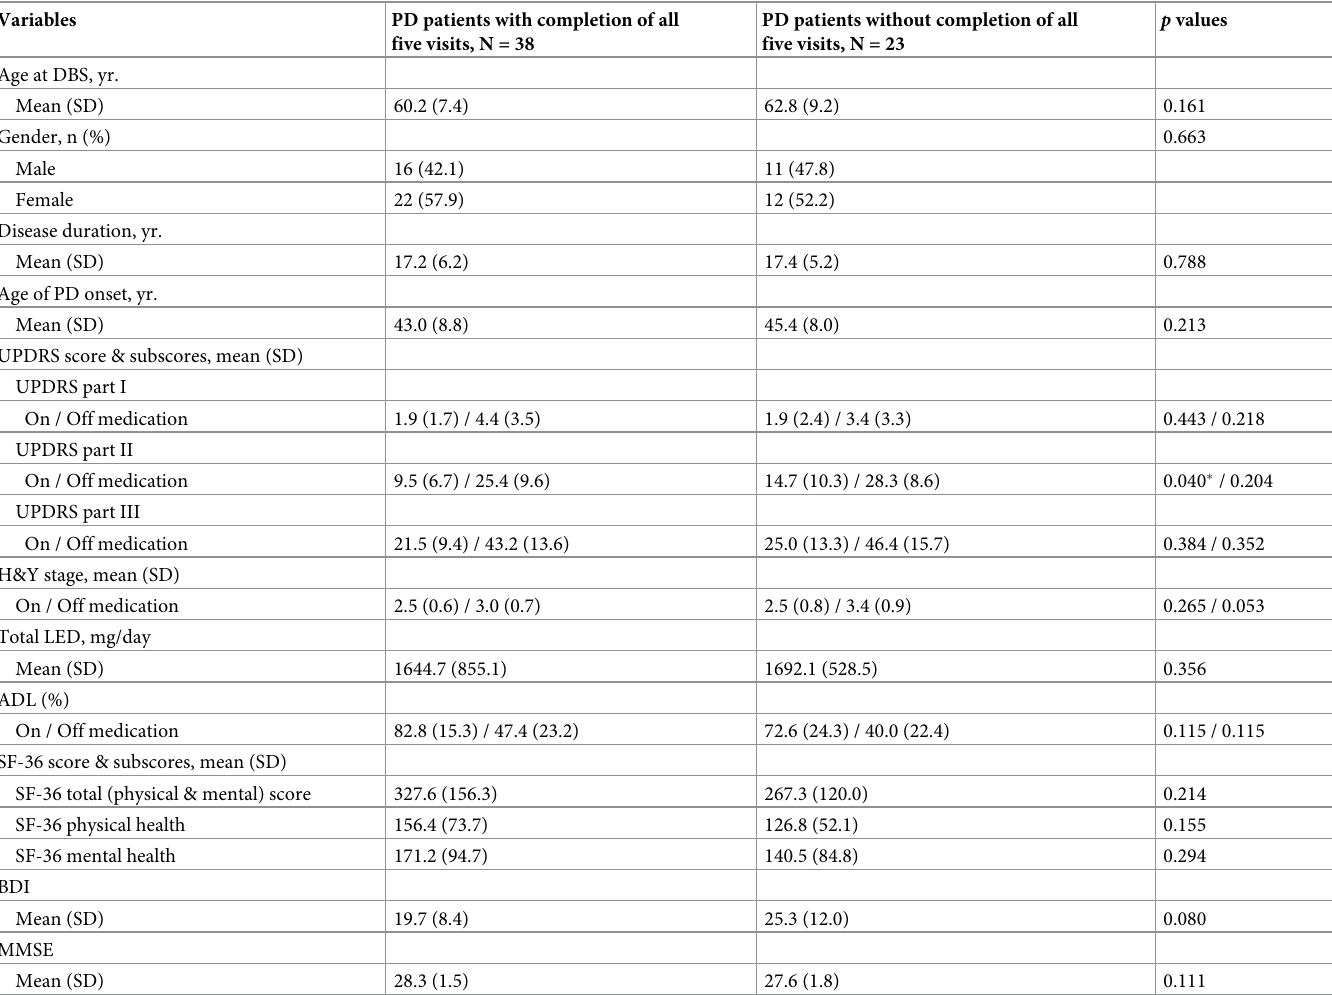
Table 2. Baseline demographics and PD-associated characteristics of the patients with or without completion of all five visits in this study. Variables PD patients with completion of all PD patients without completion of all p five visits, N = 38 five visits, N = 23